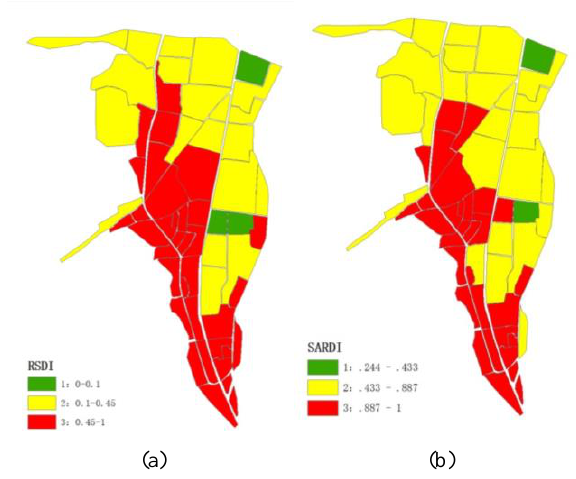
Figure 9. The classification maps of the seismic damage based on RSDI by visual interpretation from the airborne high resolution optical image (a) (Wang et al, 2013) and SARDI by automatic extracted from airborne SAR image in this paper (b)